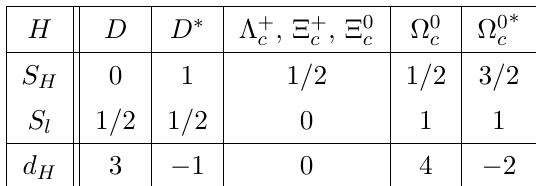
Table 6. Values of spins and of the parameter d H for all relevant particles. In all cases S h = 1 / 2 , as this is merely the spin of a single quark, and is therefore not included in the table. Values of S S l and d H ∗ for the triplet baryons Λ + of these baryons, making µ 2